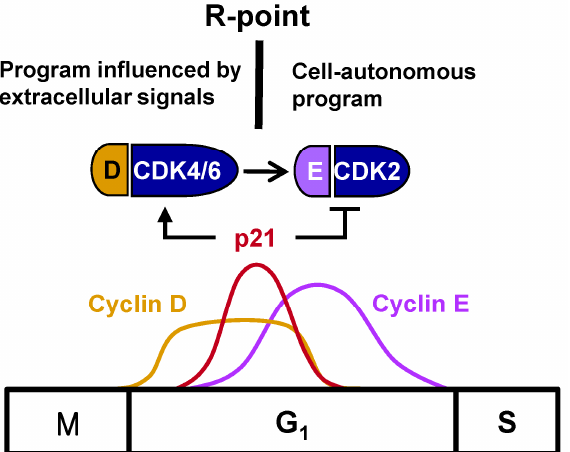
Figure 1. Fluctuation of levels of cyclins D and E and p21 through the cell cycle. The levels of cyclins D and E and p21 fluctuate markedly as cells progress through the cell cycle. The CDK inhibitors of the p21 family stimulate the formation of the cyclin D–CDK4/6 complex while inhibiting the formation of other cyclin–CDK complexes, including cyclin E–CDK2. Extracellular signals strongly influence the levels of D-type cyclins during the early G 1 phase. However, the levels of the other cyclins, including cyclin E, are controlled by intracellular signals and precisely coordinated with cell cycle progression. The cyclin E–CDK2 complex is activated after cells pass through the R-point, followed by the formation of the remaining cyclin–CDK complexes through a cell-autonomous program.